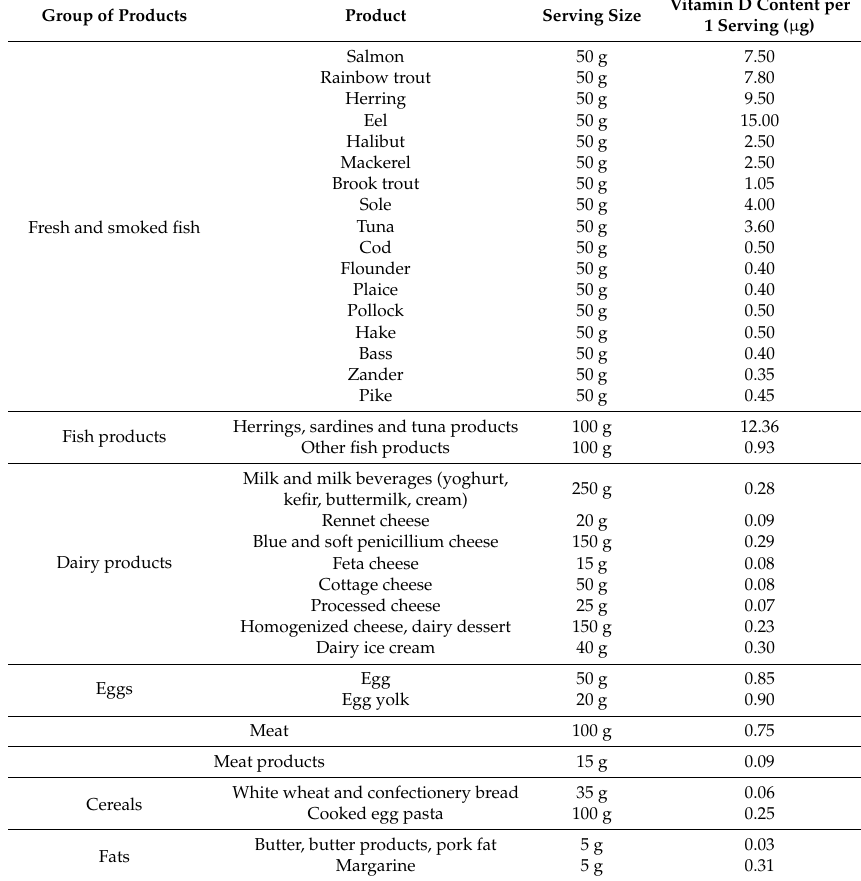
Table 2. Vitamin D contents for the single serving sizes of the products specified in the